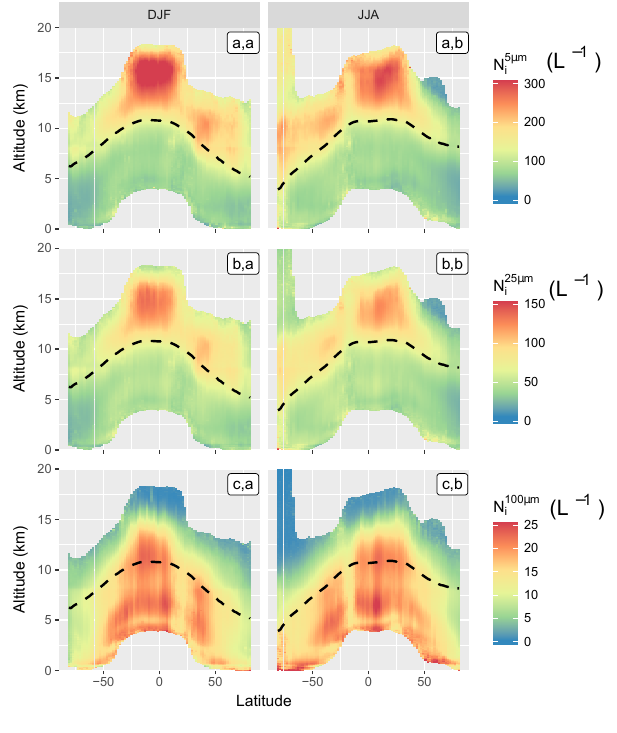
Figure 9. Zonal profiles of N 5µm (a.a; a.b) , N 25µm (b.a; b.b) and i i N 100µm (c.a; c.b) , during Northern Hemisphere winter (DJF; a.a; i b.a; c.a ) and summer (JJA; a.b; b.b; c.b ) seasons. The − 40 ◦ C iso- line is shown as a dashed black